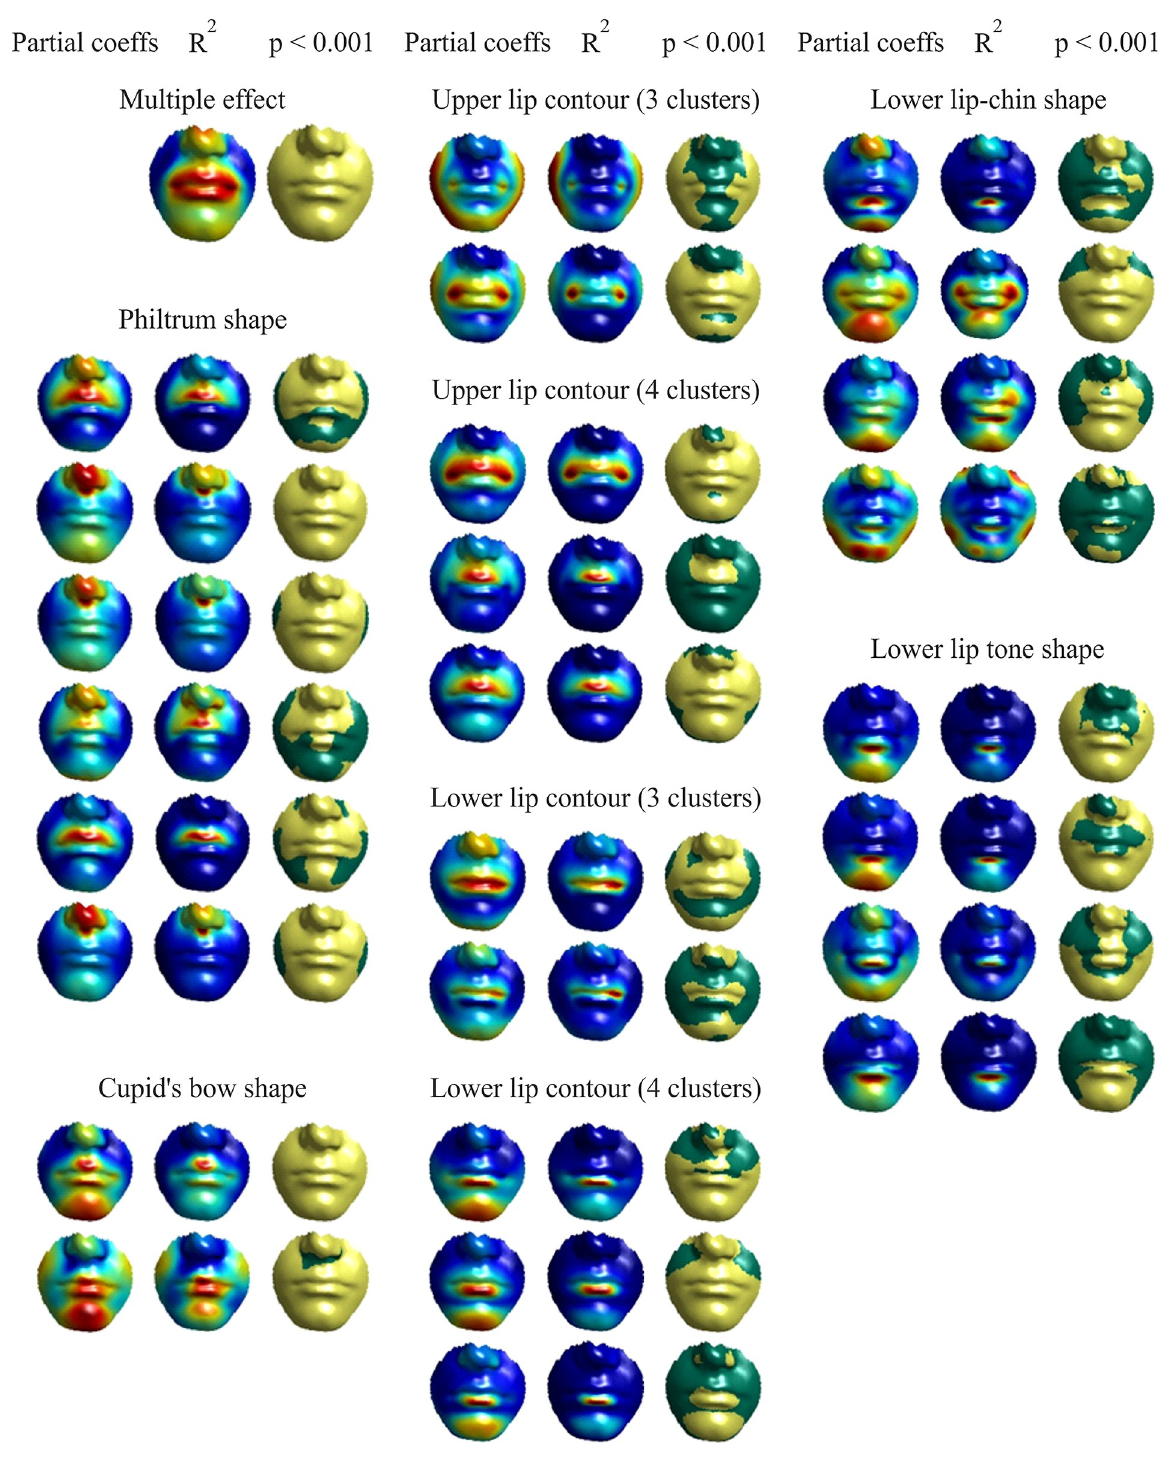
Fig 13. Visualisation of the effect of automatic categories on the lower face based on the regression results for dummy variables. The ‘Partial coeffs’ columns display heat maps of the partial regression coefficients associated with mesh vertices (warmer colours correspond to stronger effects). The ‘ R 2 ’ columns display heat maps of proportion of the variance. The ‘ p < 0.001’ columns show two-colour maps of the statistical significance of the effect: yellow for p-value < 0.001 and green for p-value � 0.001.